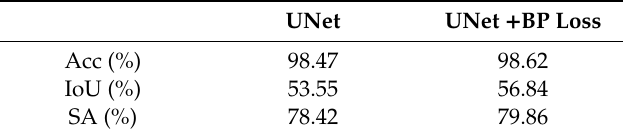
Table 4. Predicted boundary performance on the WHU